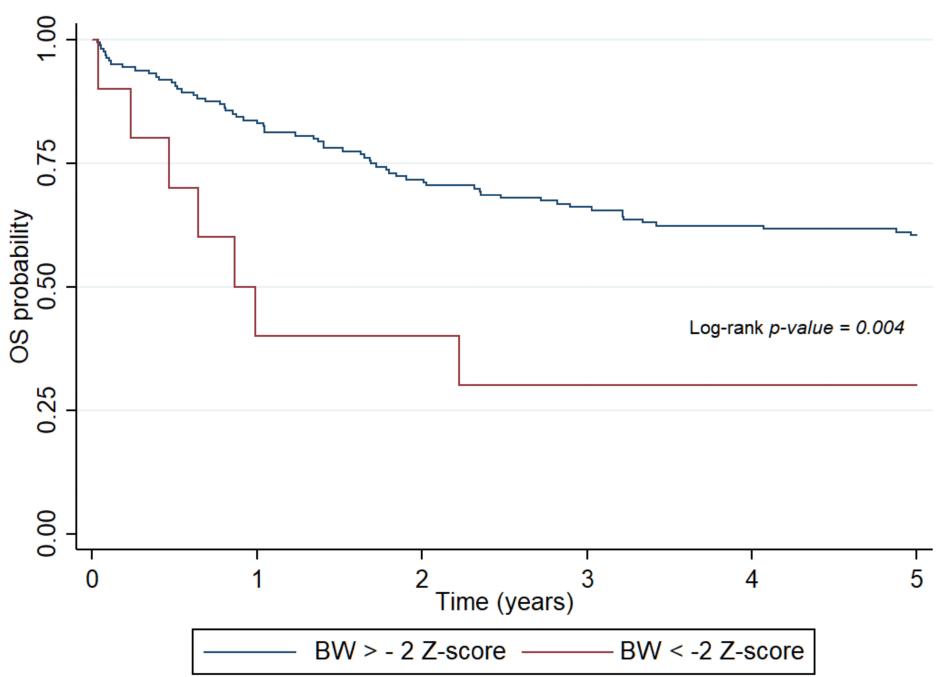
Figure 1. Probability of overall survival for patients with pediatric hematologic malignancies determined by body weight Z-score at diagnosis. OS: overall survival, BW: body weight.